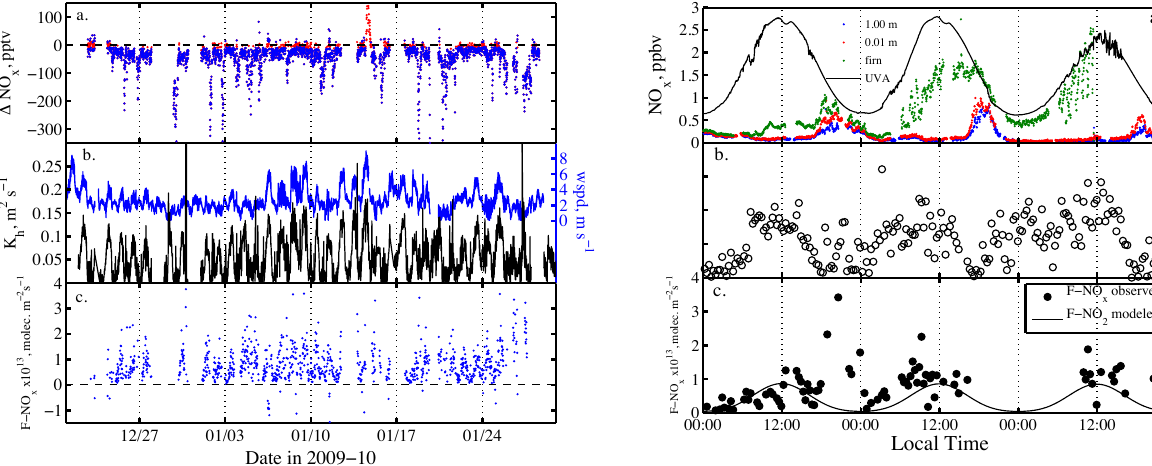
mixing (Fig. 7a). From a total of 1023 10-min average flux